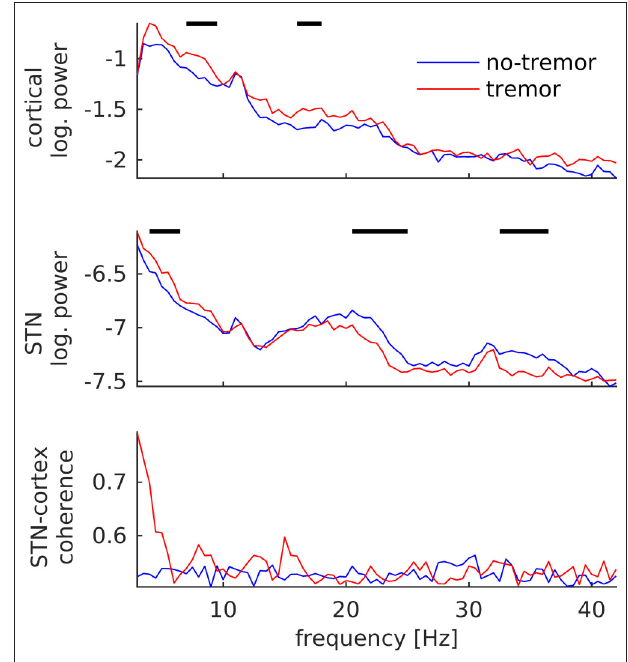
FIGURE 4 | Changes of subthalamic and cortical signals during tremor maintenance. Cortical (Top) and subthalamic (Middle) power averaged over all tremor (red) and no-tremor segments (blue). (Bottom) STN-cortex coherence. Vertical bars mark significant